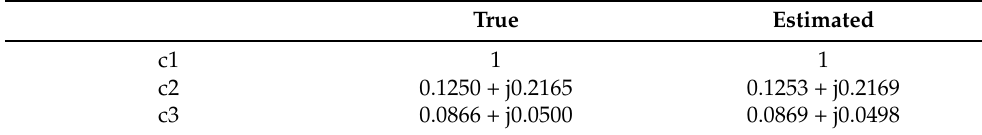
Table 3. Mutual coupling